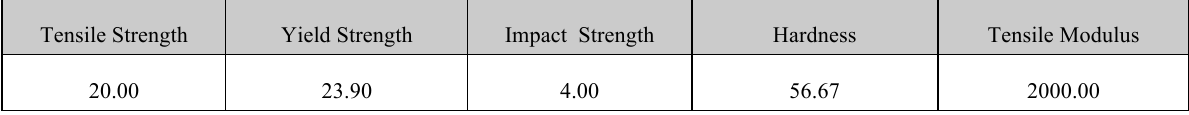
Table 1: Input parameter list associated to a material under Polymer class (Y)